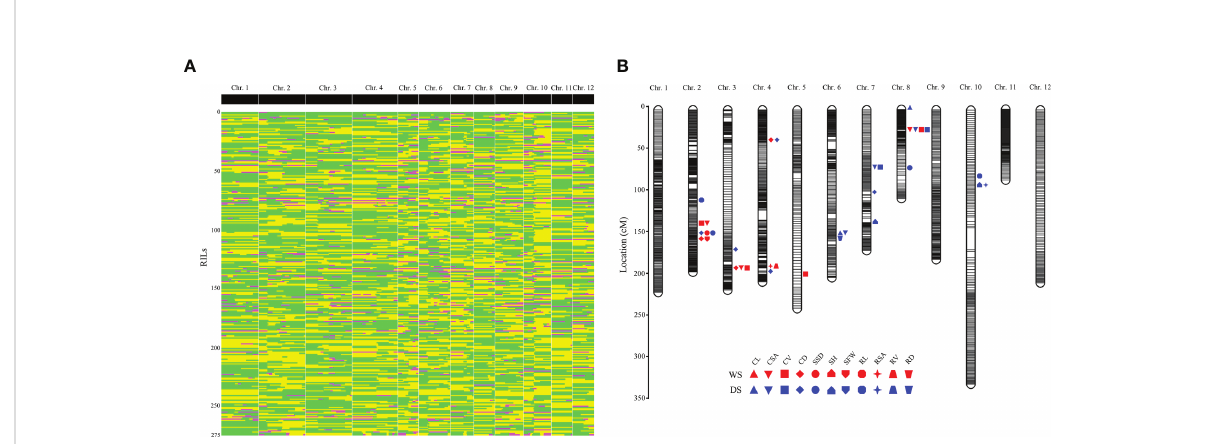
FIGURE 1 Genetic linkage map constructed with bin markers and the locations of QTLs associated with traits related to anaerobic seedling establishment. (A) Recombination bin map consisting of 2,498 bin markers. Green: CHA-1 genotype; yellow: H335 genotype; pink: heterozygote. (B) All of the QTL positions on the high-density map. The red patterns represent the QTLs detected during the wet season (WS); the blue patterns represent the QTLs detected during the dry season (DS). The words associated with different shapes are abbreviations of different phenotypes: CL, coleoptile length; CSA, coleoptile surface area; CV, coleoptile volume; CD, coleoptile diameter; SSD, shoot stem diameter; SH, shoot height; SFW, shoot fresh weight; RL, root length; RSA, root surface area; RV, root volume; RD, root